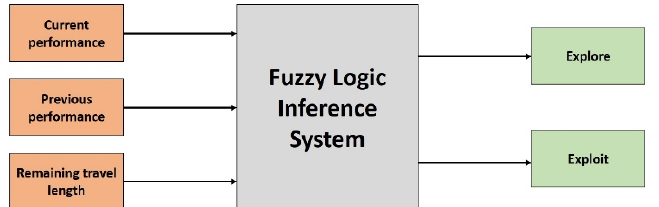
Figure 19. Sketch of the proposed fuzzy logic inference system (FIS) utilised for dynamic search strategy selection.